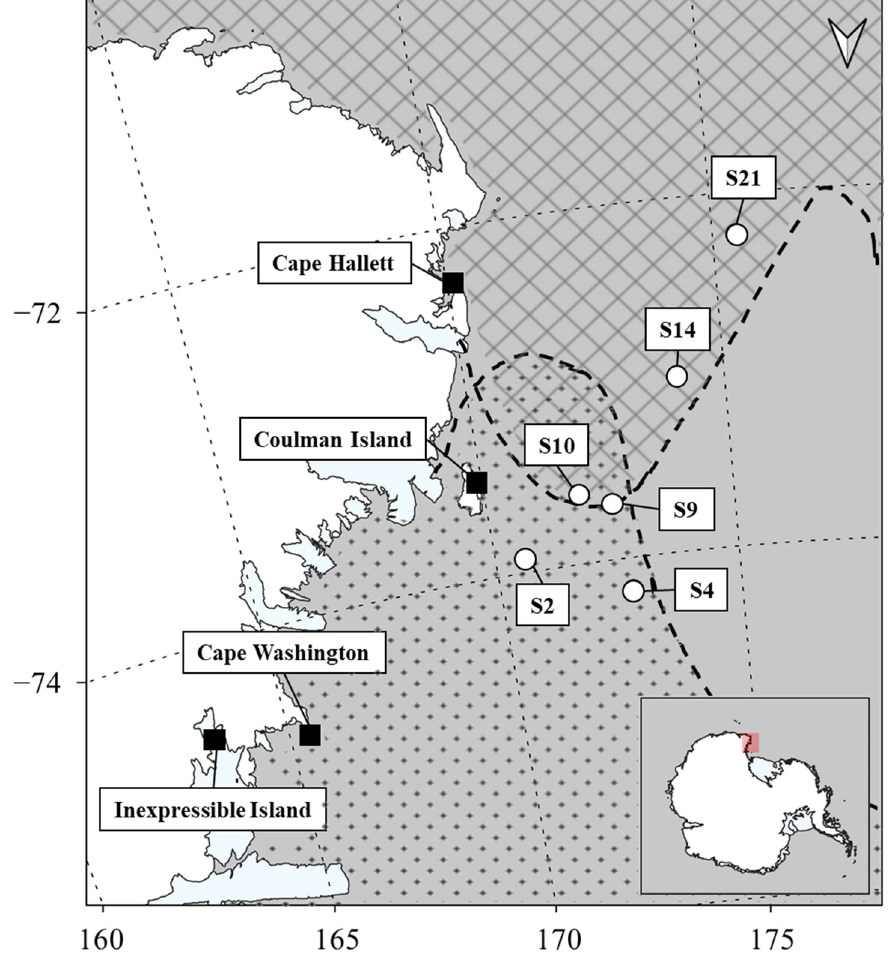
Figure 1. Study area. Penguin colonies (square), krill sampling area (white circle), distribution of Antarctic krill (cross line), and distribution of ice krill (dot pattern) in the western Ross Sea, Antarctica. Distribution of krill modified from the Ross Sea Region Marine Protected Area Research and Monitoring Plan, CCAMLR. Details are presented in Table 1.